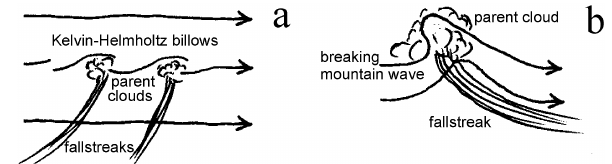
Fig. 1. Vertical cross sections showing the different pointing direc- tions of fallstreaks caused by supersaturated air flowing through (a) Kelvin-Helmholtz instabilities and (b) breaking mountain waves. The fallstreak direction depends on the shear vector between the parent cloud and the fallstreak. In (a), the wind speed is increasing with